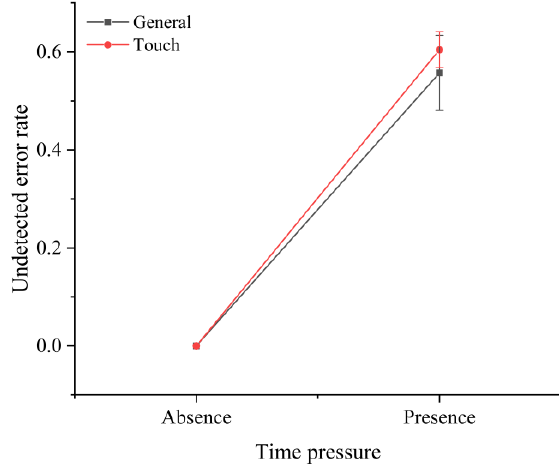
Figure 7. Interaction effect between screen type and time pressure on the disposition error rate.